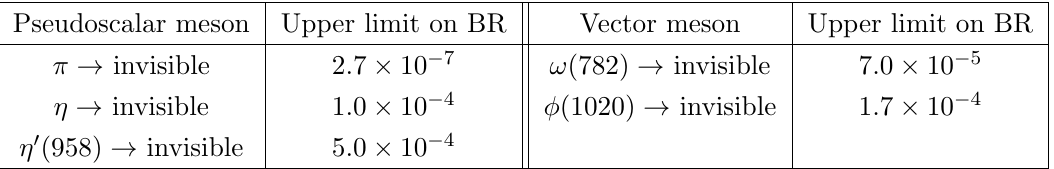
Table 2 . Relevant constraints on the invisible decays of pseudoscalar mesons J PC = 0 (cid:0) + and vector mesons J PC = 1 (cid:0)(cid:0)